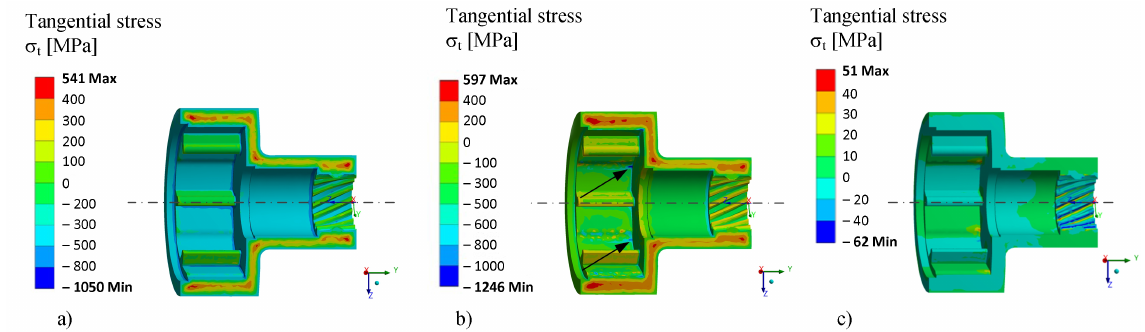
Figure 6. Radial stresses in the starter clutch barrel ( a ) after the heat treatment, ( b ) at the time of operation and ( c ) without the consideration of heat treatment at the time of operation.